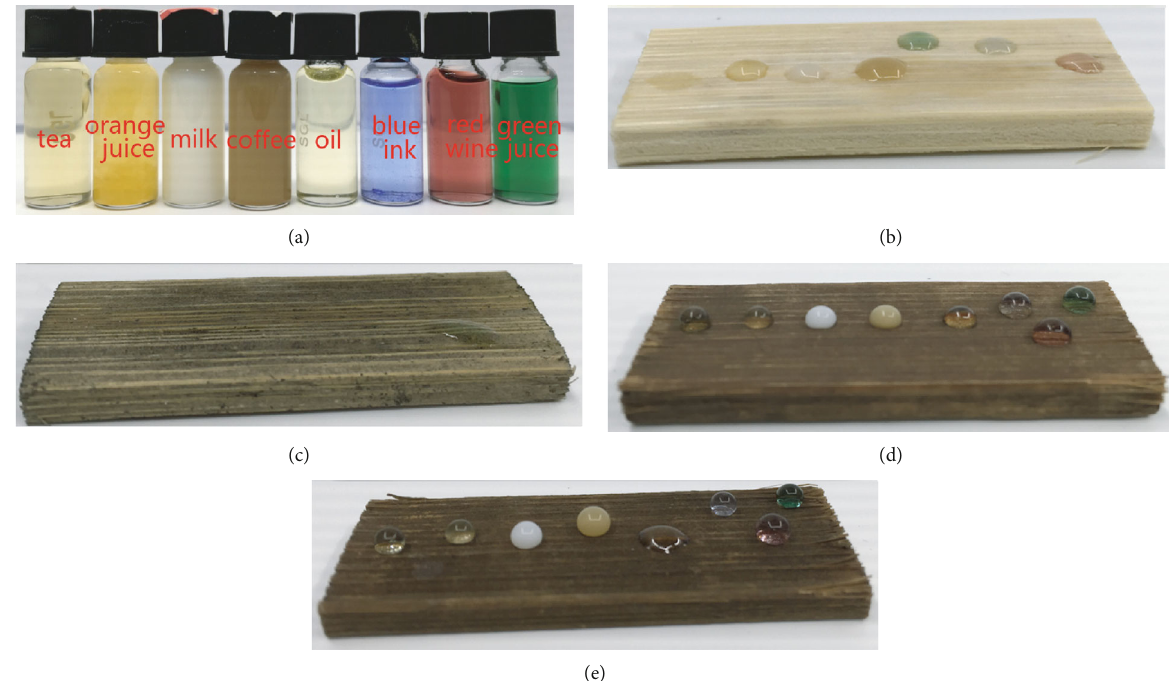
Figure 8: Digital photos of (b) BT, (c) RGOBT, (d) RGO@SiO in daily life.